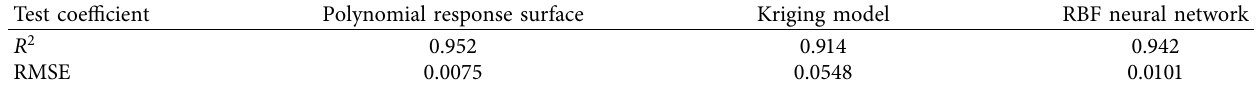
Table 17: Accuracy test of approximate model in the process of vehicle climbing vertical